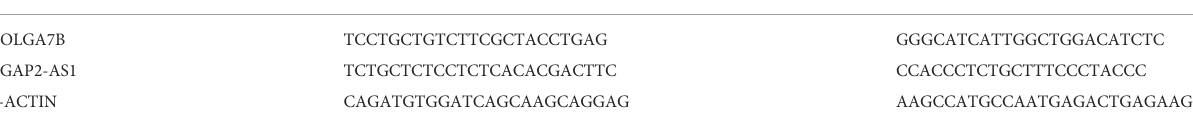
TABLE 2 The primers for target genes.